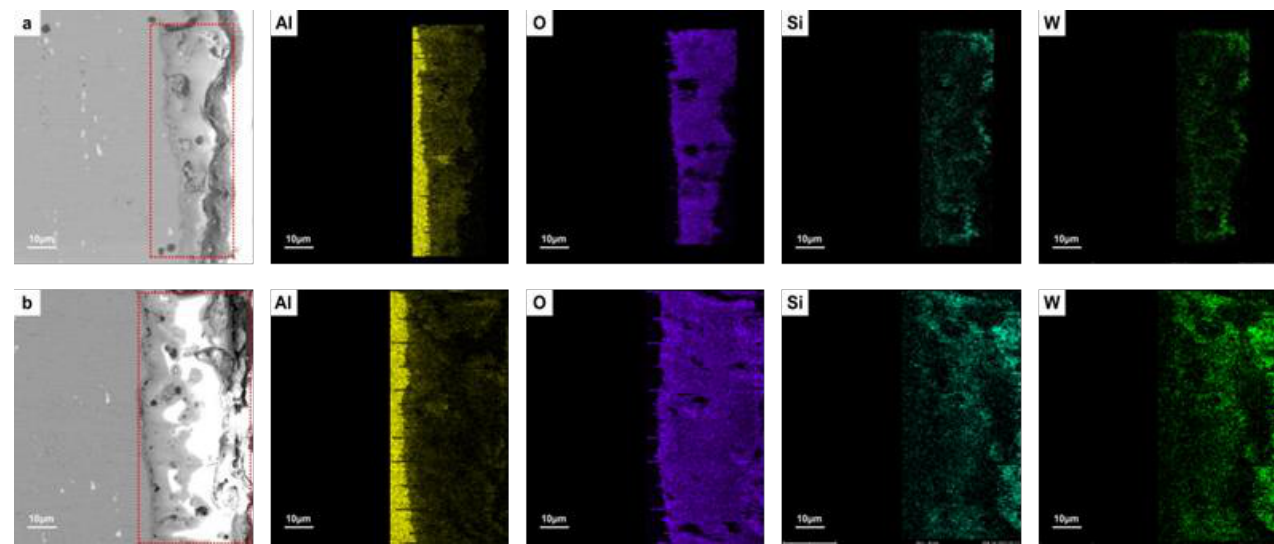
Figure 3. Cross-sectional images and element distribution of ( a ) unsealed MAO film, and ( b ) MAO film sealed with 5 g/L concentration of SiO 2 nanoparticles.